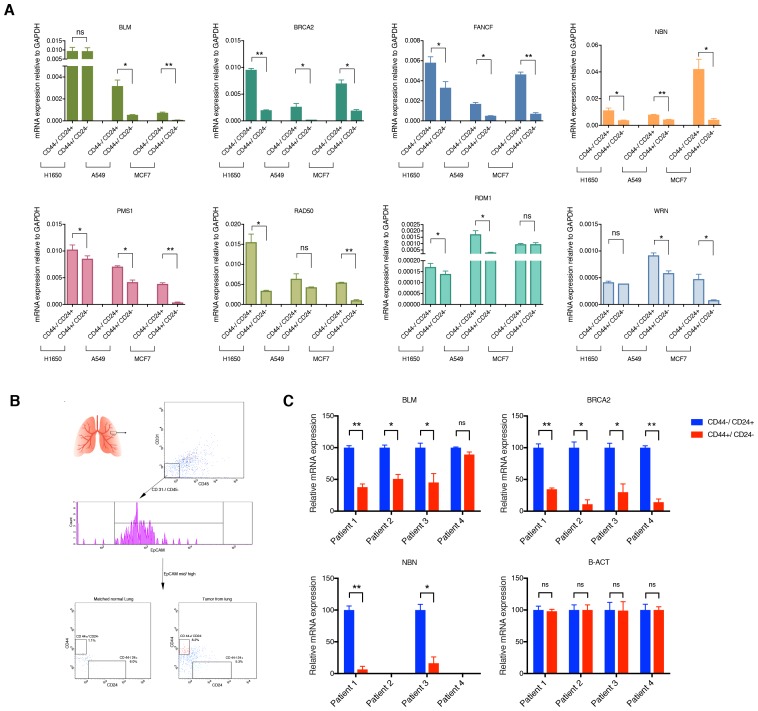
mRNA expression analysis of HDR genes in CD44−/CD24+ and CD44+/CD24− cells FACS sorted from cells lines and patient tumors.(A) Comparative expression of the indicated HDR genes in FACS-sorted CD44+/ CD24− cells relative to CD44−/ CD24+ cells from H1650, A549 and MCF7. mRNA expression was quantified by RT-qPCR. Each bar is the mean ± SD of three replicates from two different experiments and represents mRNA expression of the indicated gene. p-value *<0.05, **<0.005, unpaired t-test. (B) Schematic of cell sorting from tumors. Tumor-derived single cell suspension was stained with antibodies against CD45, CD31, EpCAM, CD44, and CD24. CD45-; CD31-; EpCAM+ cells were then FACS sorted according to the immune types CD44+/CD24− and CD44−/CD24+. (C) Expression of BLM, BRCA2, NBN and B-ACT genes in FACS sorted CD44−/CD24+ and CD44+/CD24− cells from four NSCL tumors. B-ACT was used as a housekeeping control gene. Each bar represents the mean ± SD of three replicates. p-value *<0.05, ***<0.0005, unpaired t-test.